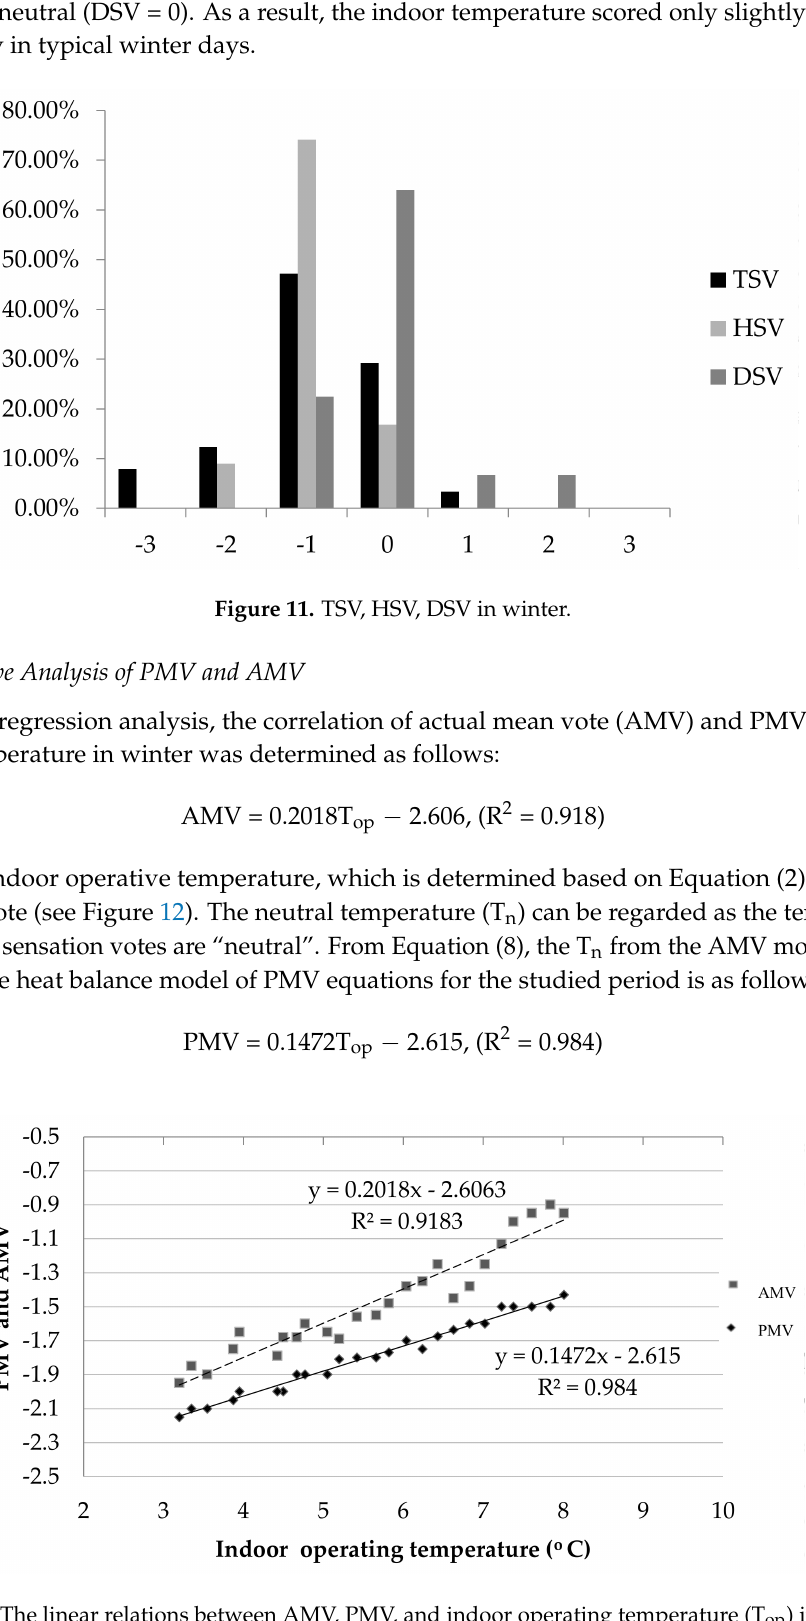
Figure 12. The linear relations between AMV, PMV, and indoor operating temperature (T op ) in